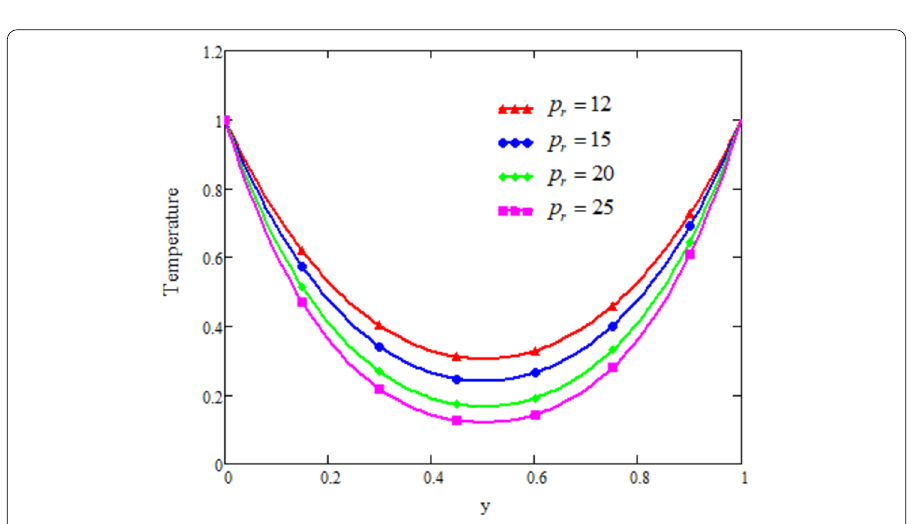
Figure 3 Temperature curves along P r variation and α = 0.5, t =